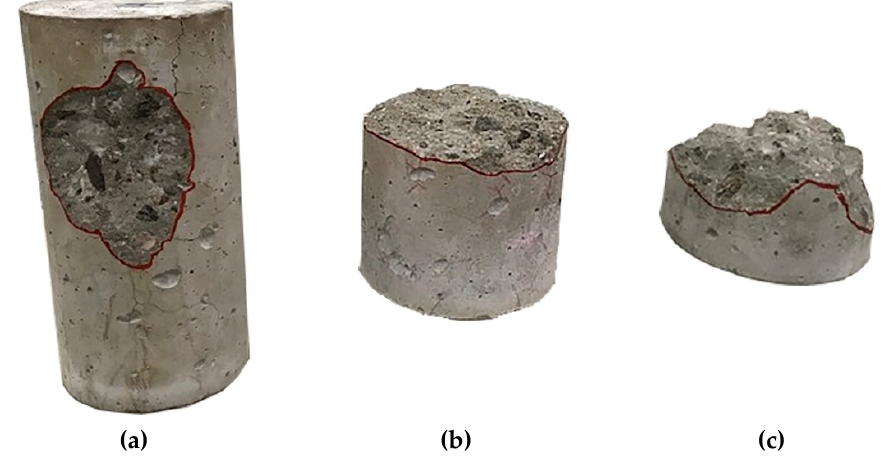
Figure 4. Spalling in CREF specimens: ( a ) Level 2–Medium severity; ( b ) and ( c ) Level 3–High Severity.